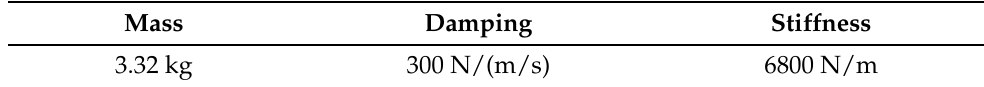
Table 1. The parameters of the